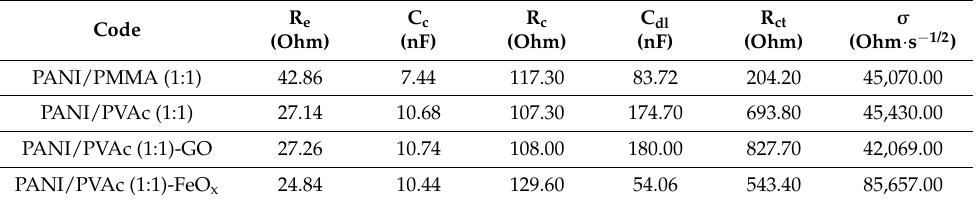
Table 2. Values of the elements in equivalent circuits of Figure S6 fitted in the Nyquist diagrams of Figure